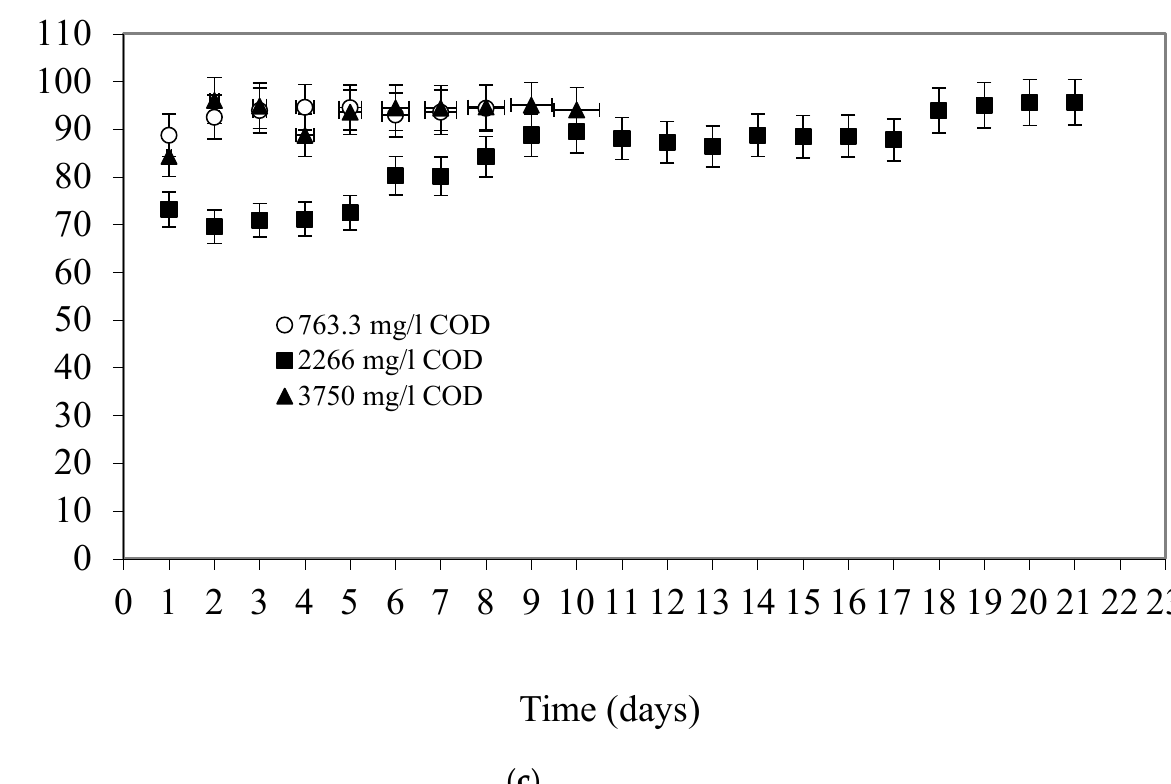
Figure 4. COD removal efficiency of SS-FFBR at various HRTs of ( a ) 8 h; ( b ) 12; ( c ) 16.